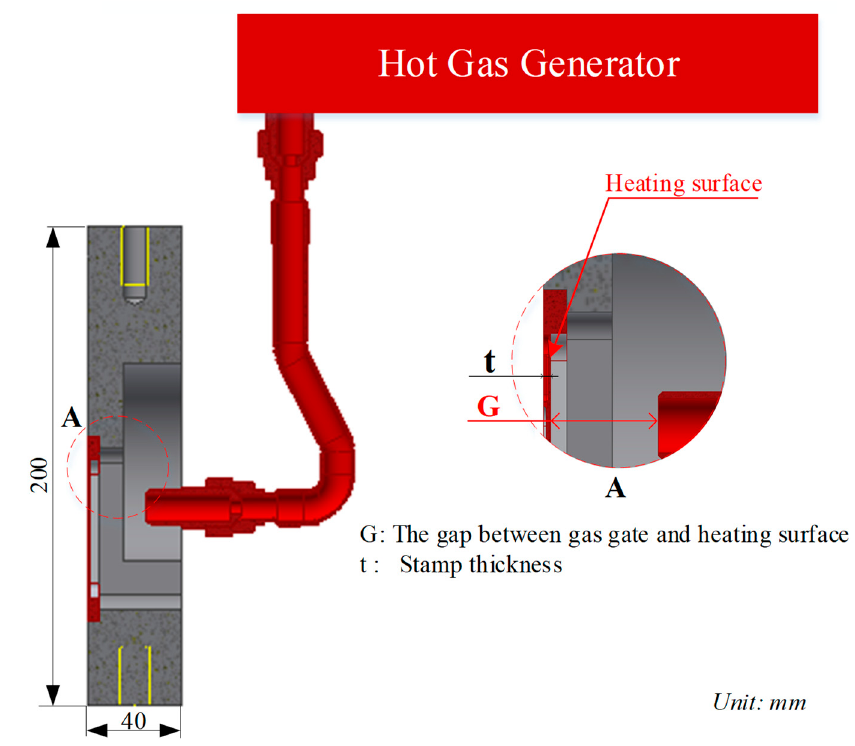
Figure 6. Mold structure at the heating position.